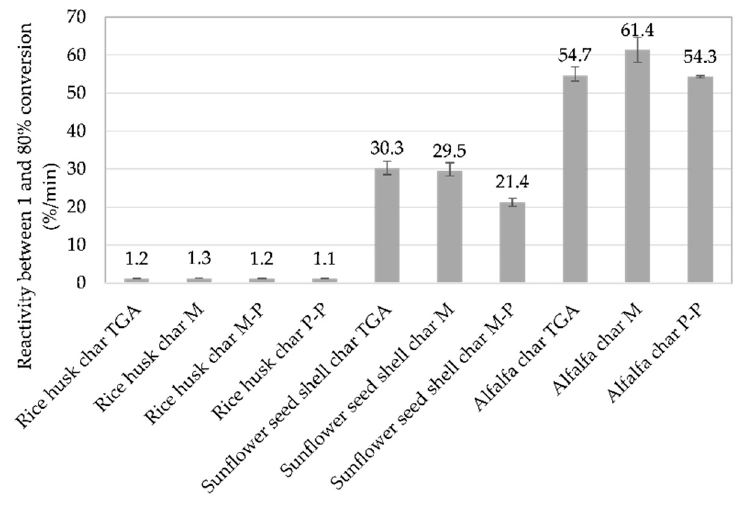
Figure 10. Gasification average reactivity between 1% and 80% conversion of biomass and char samples (see Table 2).